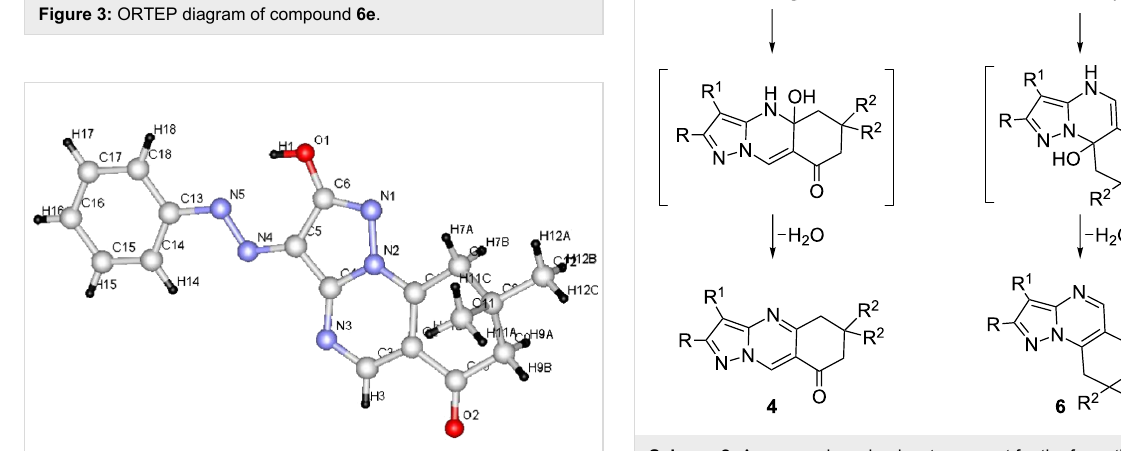
Scheme 2: A proposed mechanism to account for the formation of products 6 . The factors that determine the nature of the end product are, however, at present unclear.